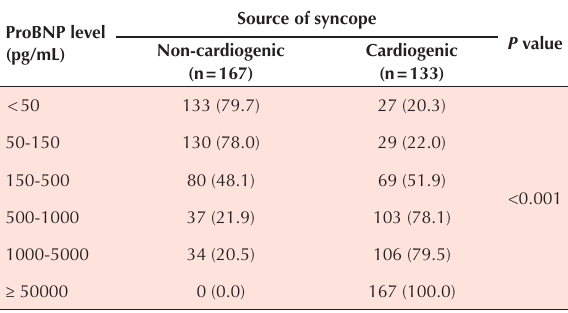
Table 2. Comparing the frequency of different proBNP ranges between patients with cardiogenic and non-cardiogenic syncope ProBNP level